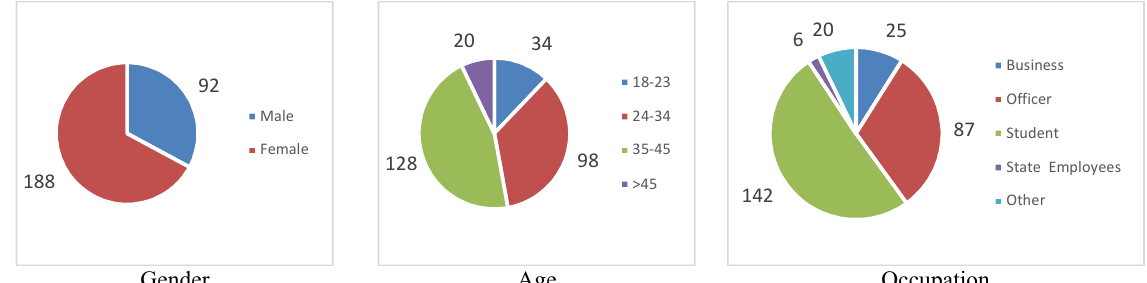
Fig. 2. Personal characteristics of the participants